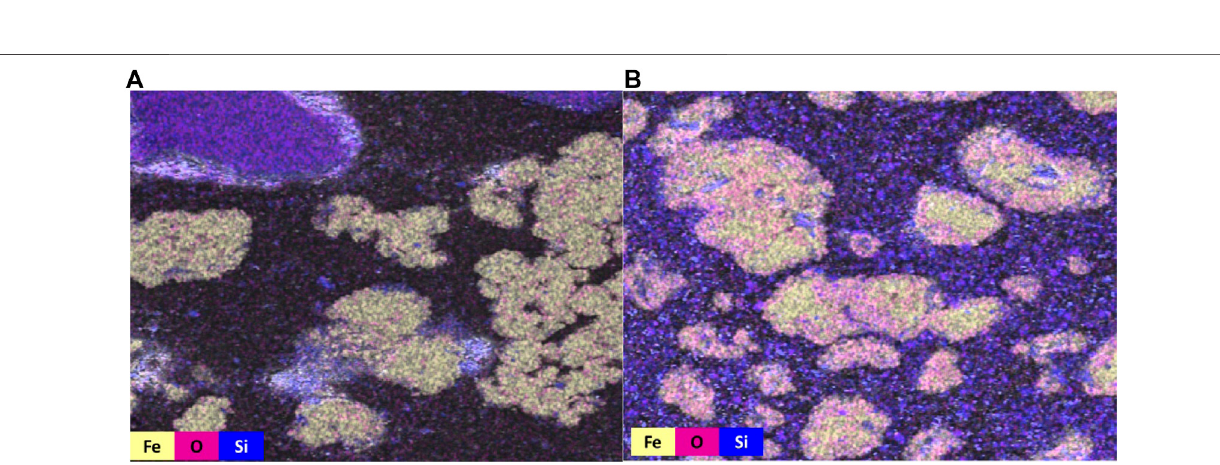
Frontiers in Chemical Engineering |